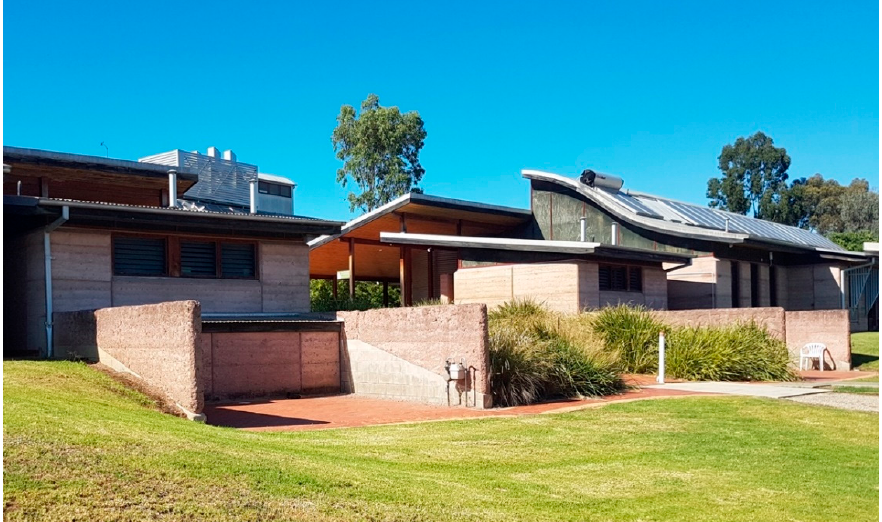
Figure 7. Uncapped pisé wing walls (walls 3 to 6), as seen from the northeast. Building 761 (right) and building 762 (left).